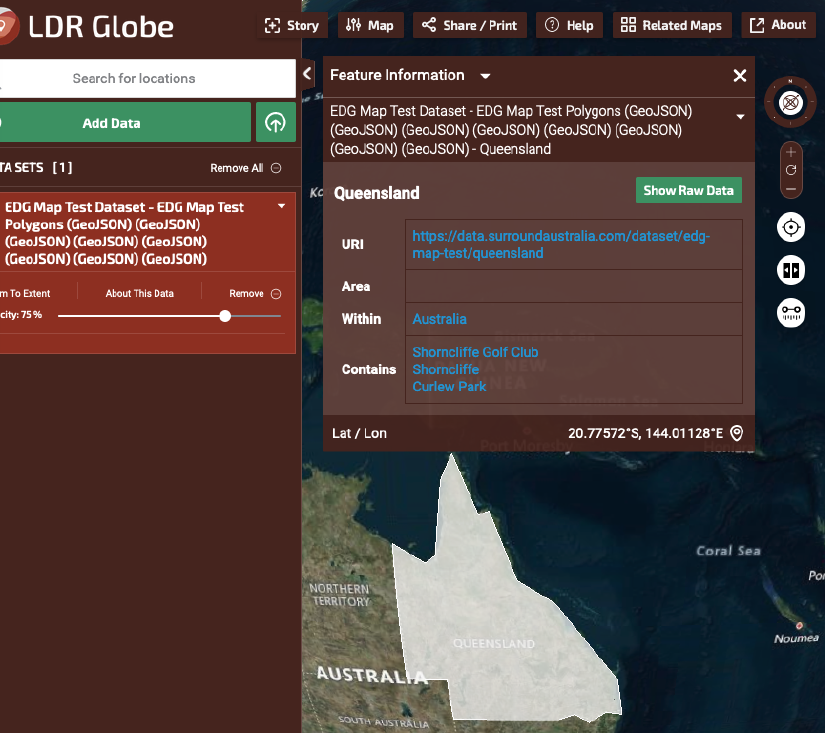
Figure 9. A development version of Australia’s "National Map" software showing data sourced from a GeoSPARQL 1.1 RDF dataset. The dialog box on the map interface shows features related to the ‘Queensland’ feature via Simple Features relations such as geo:sfWithin that the National Map software has previously not been able to